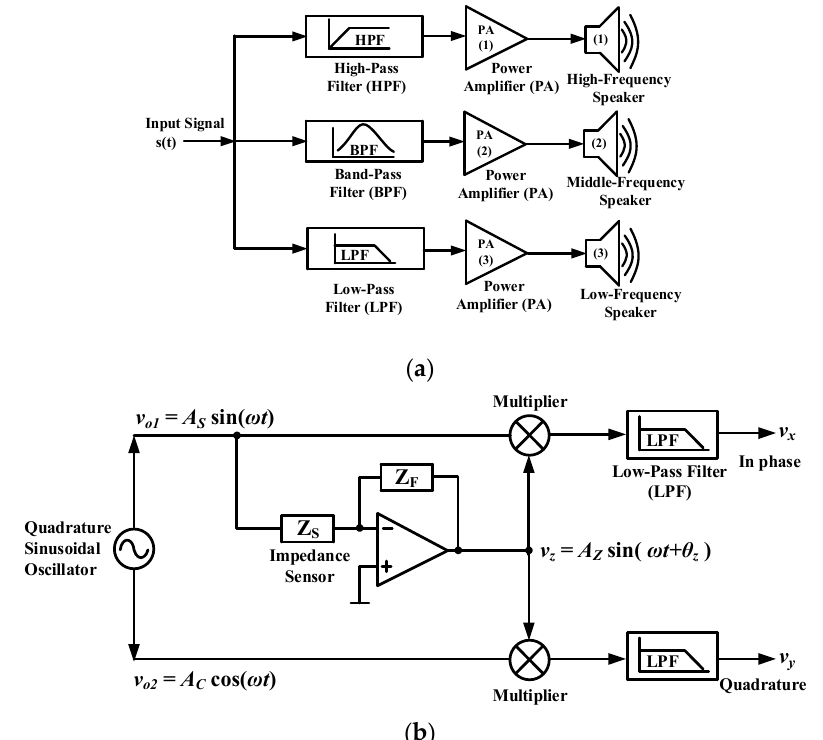
Figure 1. Basic block diagram of the three-way high-fidelity loudspeaker crossover network and phase sensitive detection (PSD) system. ( a ) Triple-section crossover network for high-fidelity loudspeakers [4]; and ( b ) the PSD system [5].